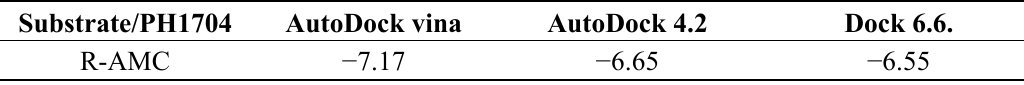
Table 1. The docking scores between R-AMC and PH1704 calculated with AutoDock vina, AutoDock 4.2 and Dock